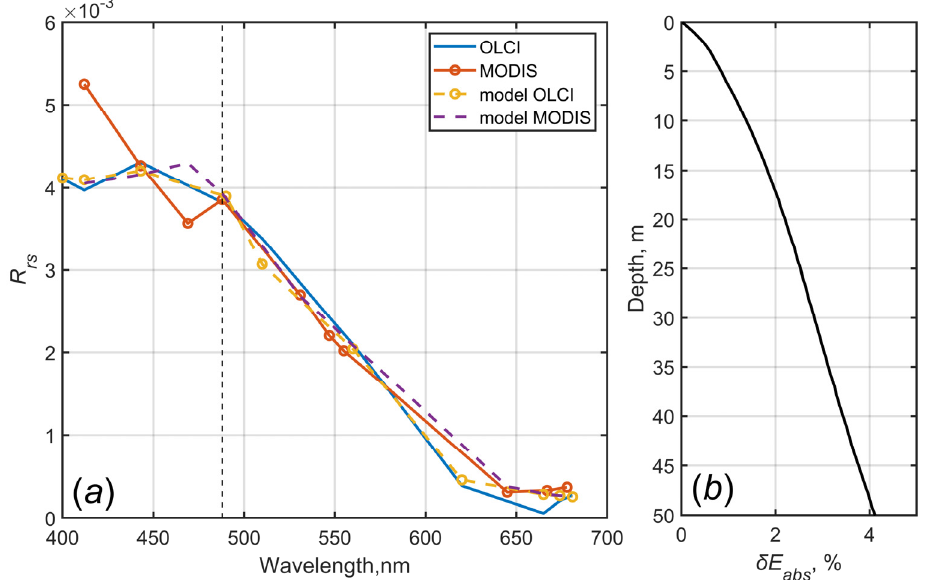
Figure 10. R rs spectra obtained from MODIS and OLCI data (solid lines) and as a result of modelling (dashed lines); the vertical dotted line shows the cutoff area of short-wavelength MODIS channels ( a ); relative deviation of absorbed energy calculated using different R rs spectra: full OLCI and shortened MODIS ( b ).